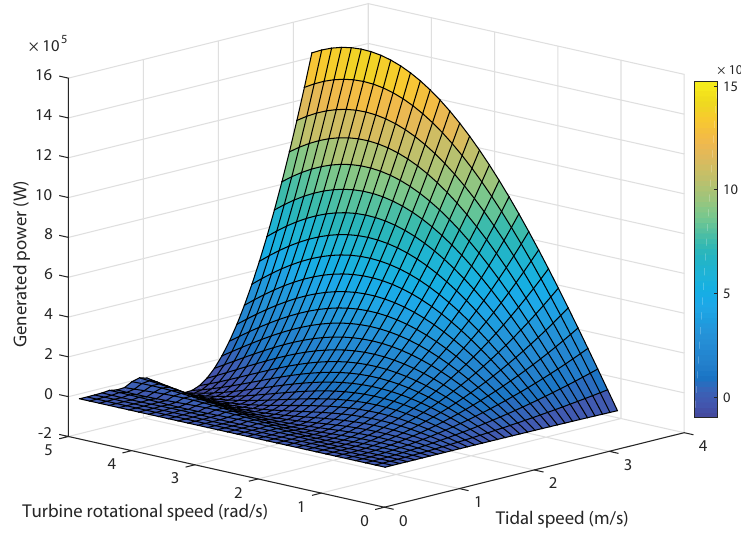
Figure 4. Generated power versus rotational speed for different tidal speeds.